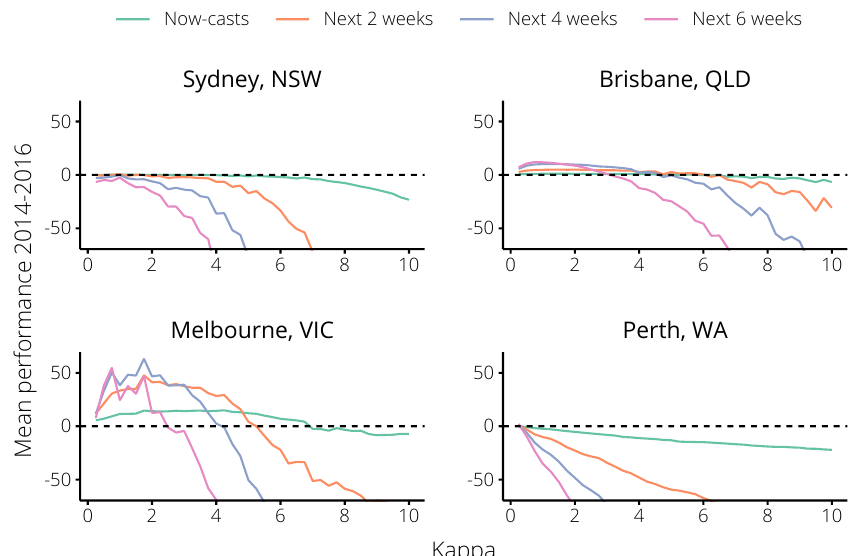
Figure 4. Mean forecast performance (cid:101) b k over the 2014–2016 influenza seasons, relative to the non-calibrated forecasts (the horizontal dashed line); (cid:101) b k > 1 indicates substantial performance improvement, and (cid:101) b k < − 1 indicates substantial performance reduction. Performance was measured against four different targets (see text for details), over a range of values for the scaling parameter κ . For small values of κ , forecast calibration significantly increased skill in Brisbane and Melbourne, had little effect in Sydney, and decreased skill in Perth.